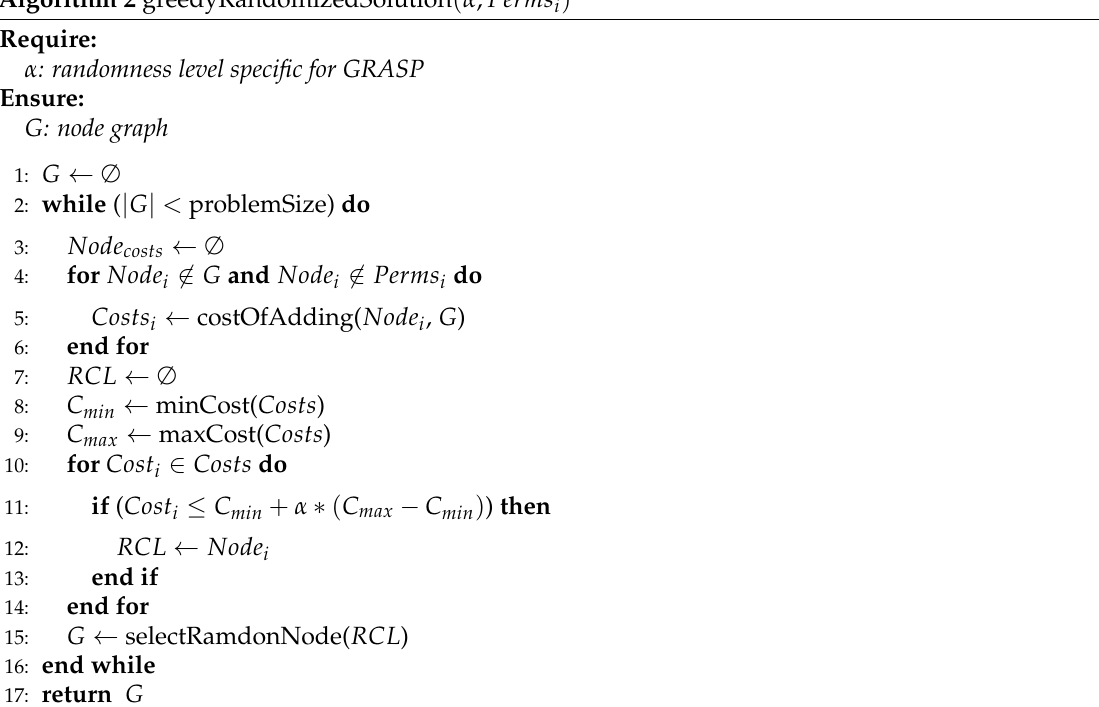
Algorithm 2 greedyRandomizedSolution ( α , Perms i